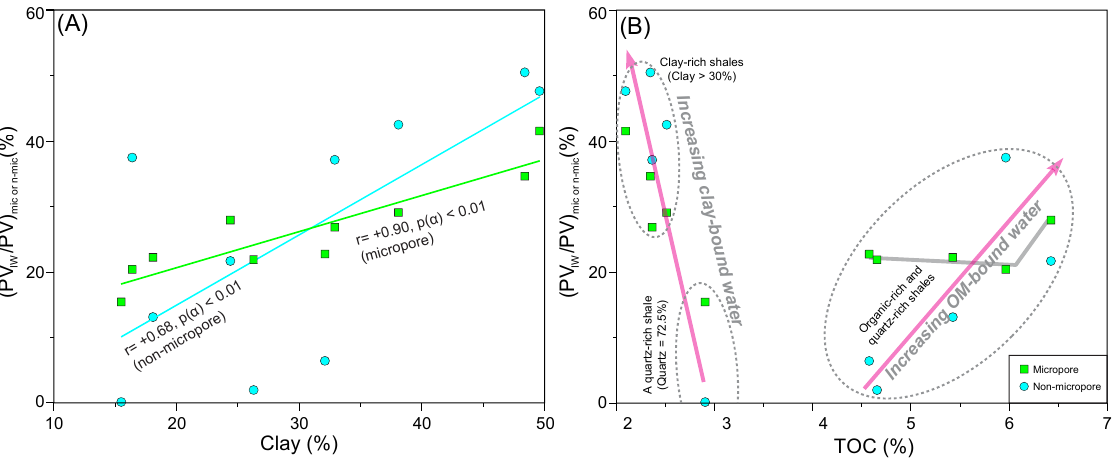
Figure 9. Cross-plots of the (V IW /V) mic or (V IW /V) n-mic ratios versus ( A ) clay content, and ( B ) TOC content of the studied WF–LMX shales from the Well PS1.